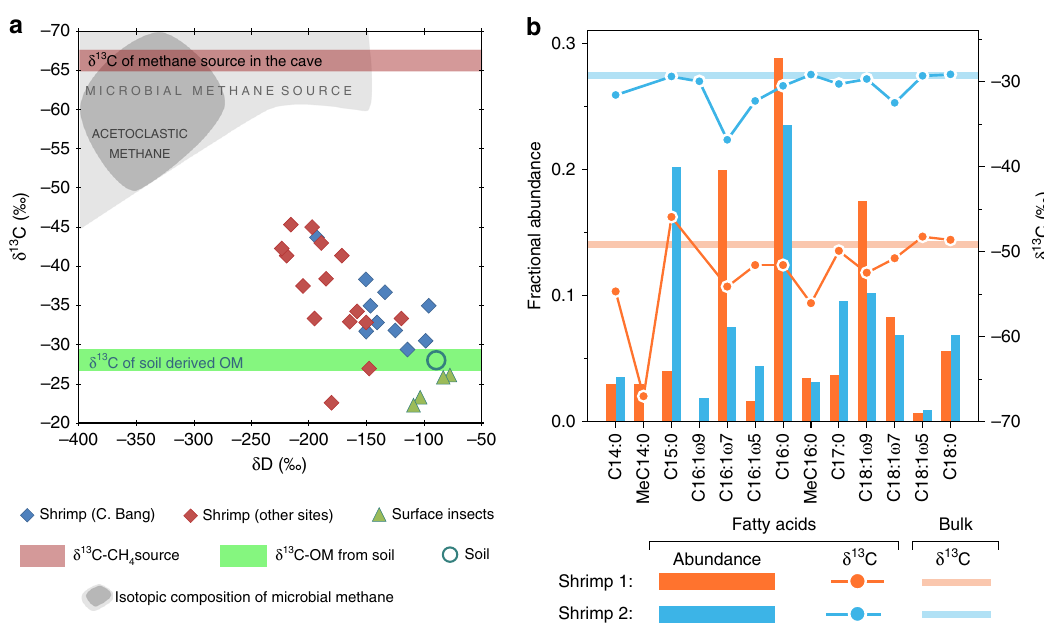
Fig. 5 Stable isotopic content of food sources and consumers. a Carbon and deuterium stable isotope ratios ( 13 C/ 12 C, 2 H/ 1 H) from stygobitic shrimp (diamonds) and surface insects (triangles) plotted relative to CH 4 and soil-derived organic matter (OM) end members. Proximity to source indicates relative trophic dependency. The δ 13 C value of methane from the MFW ( − 66.3 ± 0.7 ‰ , red shaded area) is consistent with a microbial source 29 (gray shaded area). The δ 13 C of the soil-derived OM ( − 28.0 ± 0.2 ‰ , green shaded area) includes values for forest soil, cave POC, and cave DOC. b Fatty acids from stygobitic shrimp specimens. Methane-derived carbon contribution is higher (55%) for shrimp 1 (orange) and lower (3%) for shrimp 2 (blue) based on bulk δ 13 C values ( − 49.1 ‰ and − 29.3 ‰ , respectively). The combination of extremely negative δ 13 C values and bacterial origins for odd-numbered monounsaturated and methylated FAs indicates a bacterial food source that is likely to include aerobic methanotrophs. Symbols of individual data points contain the uncertainty (std. dev.) of the measured isotopic